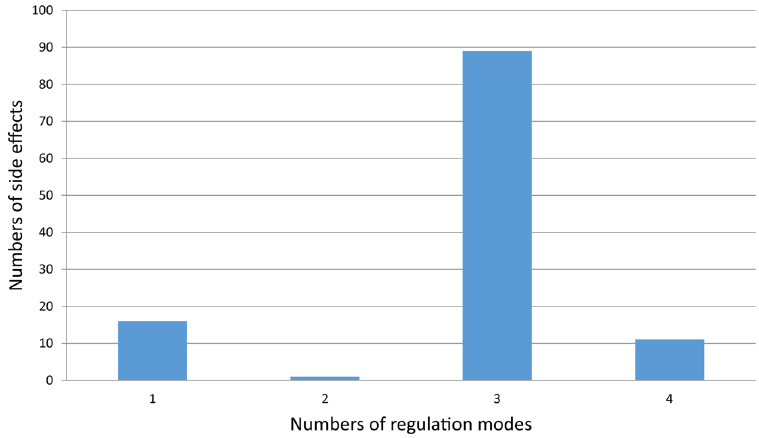
Figure 8. The distribution of side effects under different number of regulation patterns. The horizontal axis represents the number of regulation modes, and the vertical axis shows the number of side effects. For example, there are 16 side effects regulated by 1 regulation